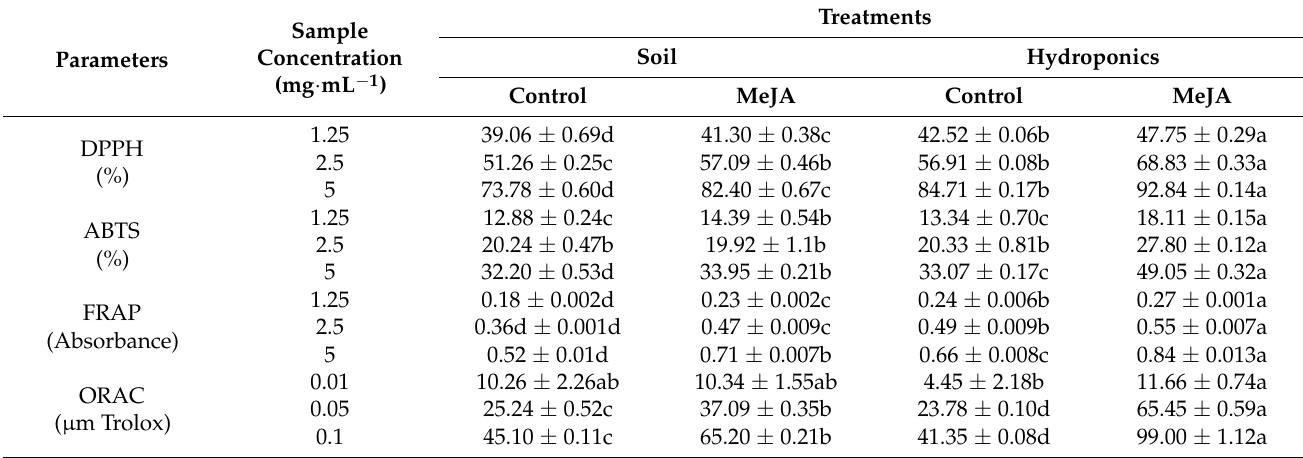
Table 2. The DPPH (2, 2-di-phenyl-1-picrylhydrazyl) radical scavenging capacity, Trolox-equivalent antioxidant capacity (ABTS), ferric-reducing antioxidant power (FRAP), and oxygen radical absorbance capacity (ORAC) of pak choi ( Brassica rapa L. ssp. Chinensis ) grown in soil or hydroponics with or without the treatment of